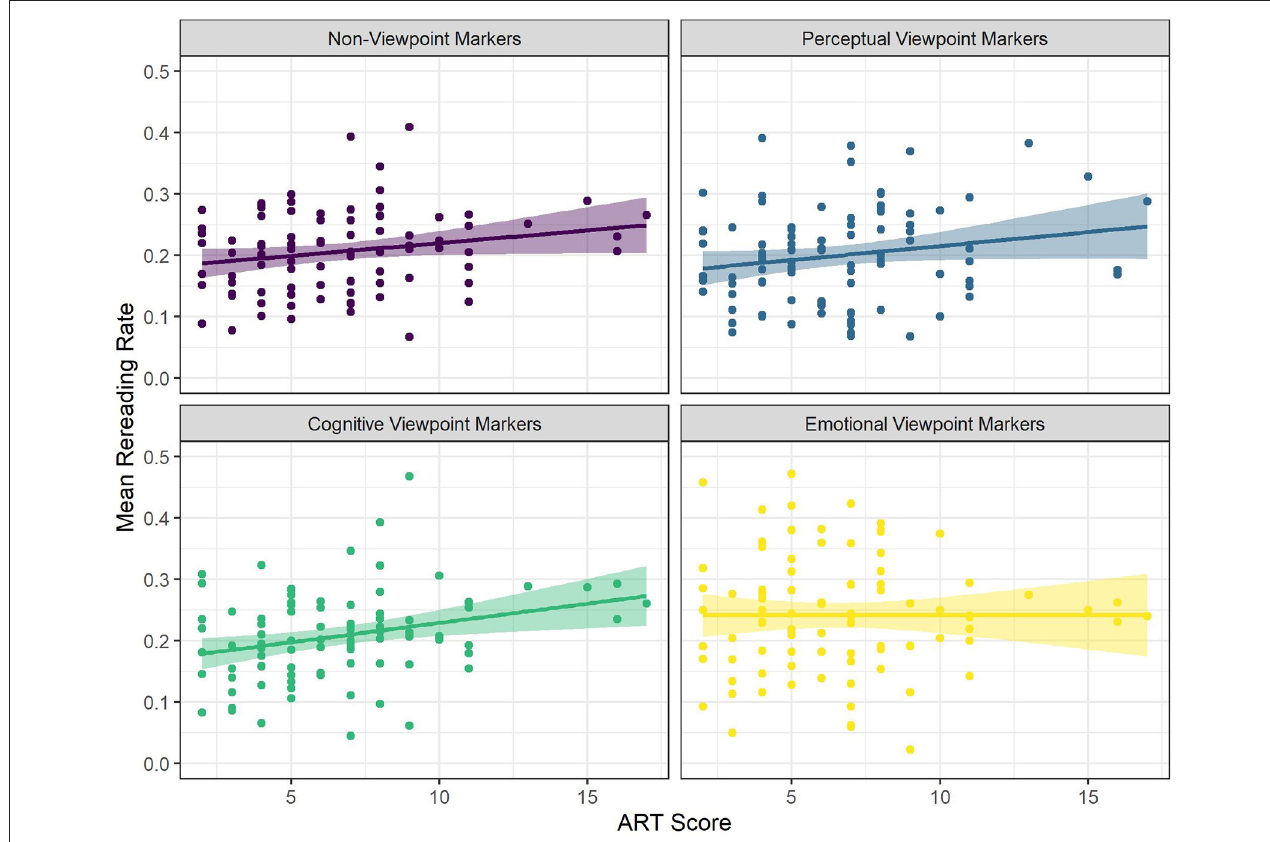
FIGURE 6 | The Relationships Between Mean Rereading Rate and ART Score for the Different Categories of Viewpoint Markers. Each Dot Represents a